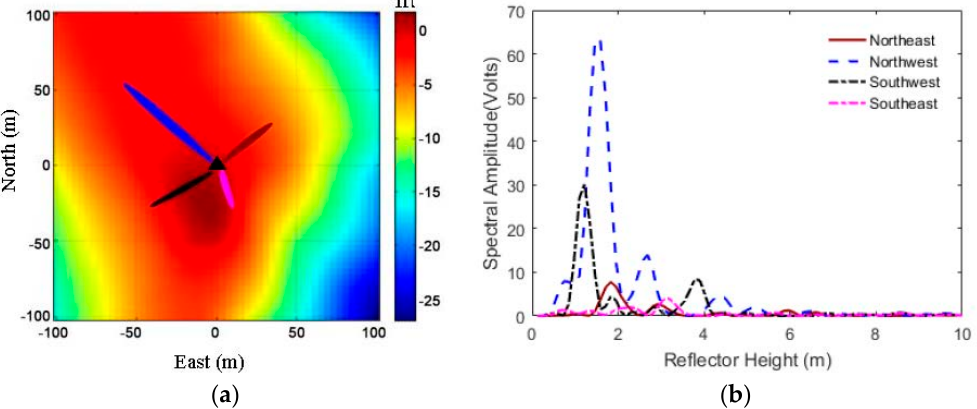
Figure 6. GPS footprints and Lomb–Scargle periodogram (LSP) curves for satellite 8 at GPS site p101 on DOY 2015-356. ( a ) Distribution of the GPS signal footprints of FFZ in different directions, with GPS site location shown in a black triangle; ( b ) LSP curves of each SNR data. Brown, blue, black, and pink lines represent GPS reflected signals in the directions of northeast, northwest, southwest, and southeast, respectively.